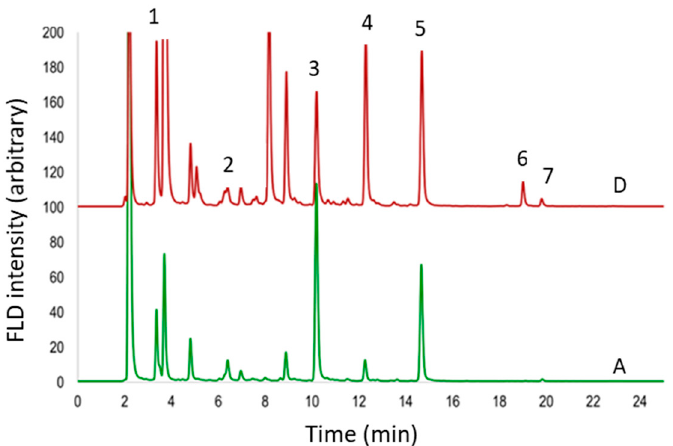
Figure 2. FLD chromatograms of two base wines of A and D qualities from Pinot Noir variety. Peak assignment: Peak assignment: 1 = Ethanolamine; 2 = Agmatine; 3 = Lysine; 4 = Cadaverine; 5 = Internal standard; 6 = Tyramine; 7 = Spermidine.